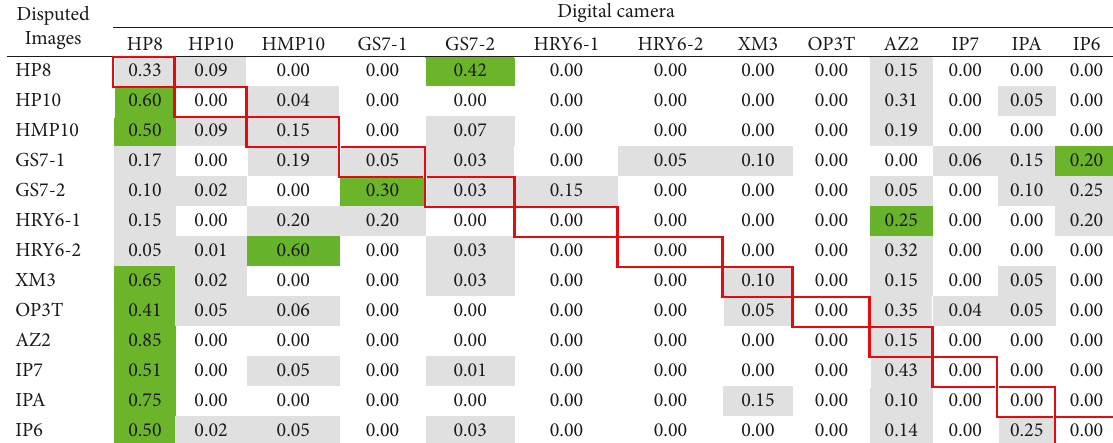
Table 3: Effectiveness of the method proposed by Quintanar-Res´endiz et al. [17] when it is applied to the second case study (reference images are flat images, and disputed images are natural